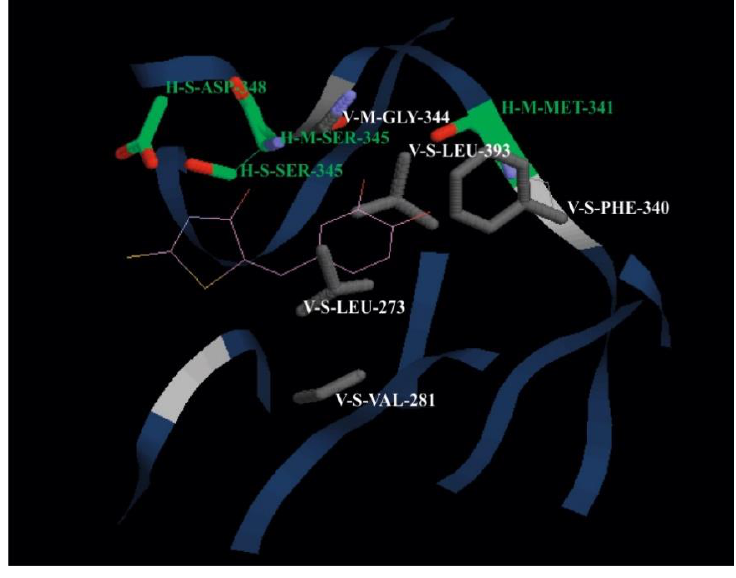
Figure 3. Interactions of the most active compound 2e with the nearby amino acid group of the tyrosine kinase Hck. The following rows show the interactions between the active compounds and the interacting residue groups. H and V indicate the interaction types (H bond and van der Waals interactions, respectively); M and S indicate the main chain and the side chain of the interacting residue, respectively. The hydrogen-bondings are coloured in green and van der Waals (white) if the energy ≤−2.5. Docking pose of ligand is pink, where yellow denotes sulphur atoms and blue nitrogen atom.